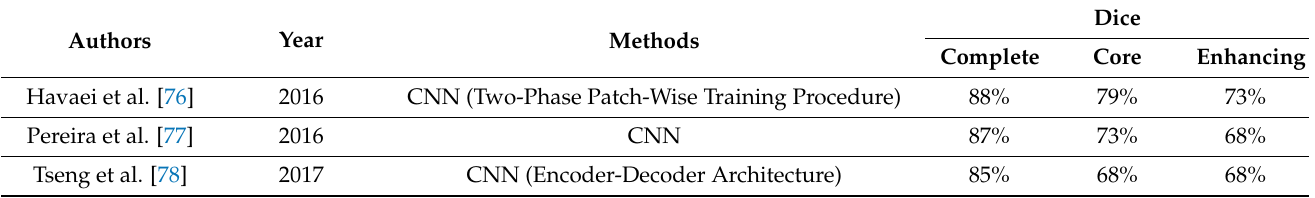
Table 9. The results of our segmentation method on the BraTS 2015 dataset, using the Dice similarity coefficient applied on complete, core, and enhancing tumors, and comparison to the